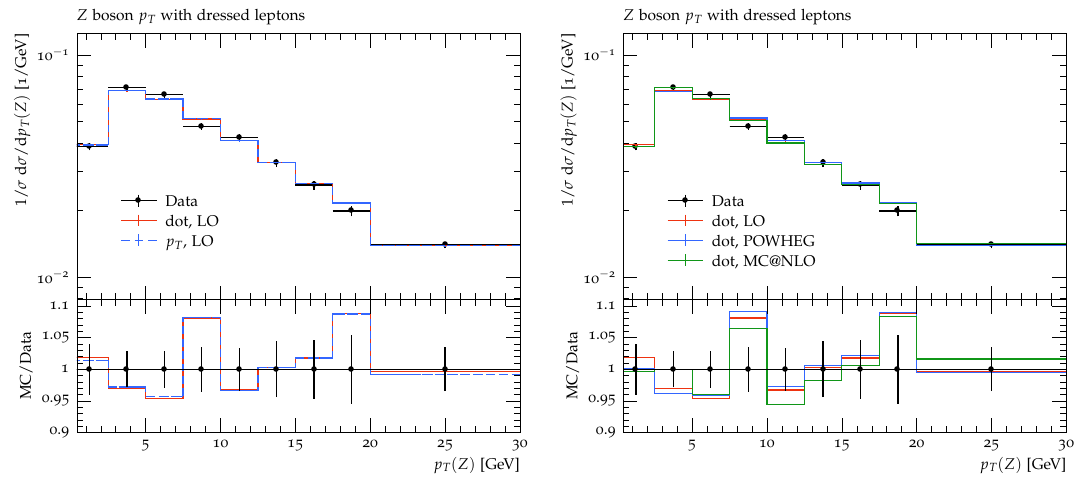
Figure 2 . Normalised differential cross section as a function of Z p ⊥ . CMS [17] data at 7 TeV compared to data generated by Herwig . In the left pane, LO (plus MEC) predictions in the dot- product and p ⊥ preserving schemes, in the right pane LO and NLO predictions in the dot-product preserving